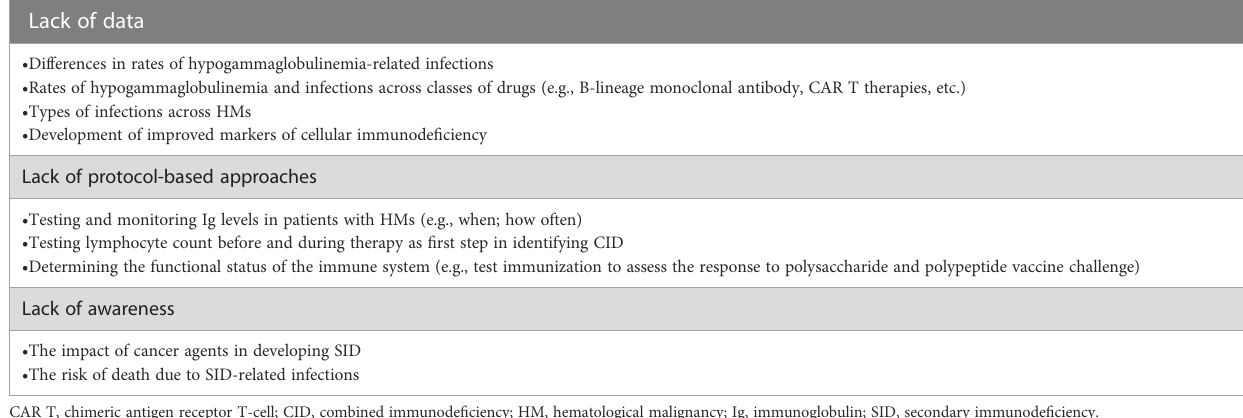
TABLE 1 Current knowledge gaps in the management of SID. Lack of data